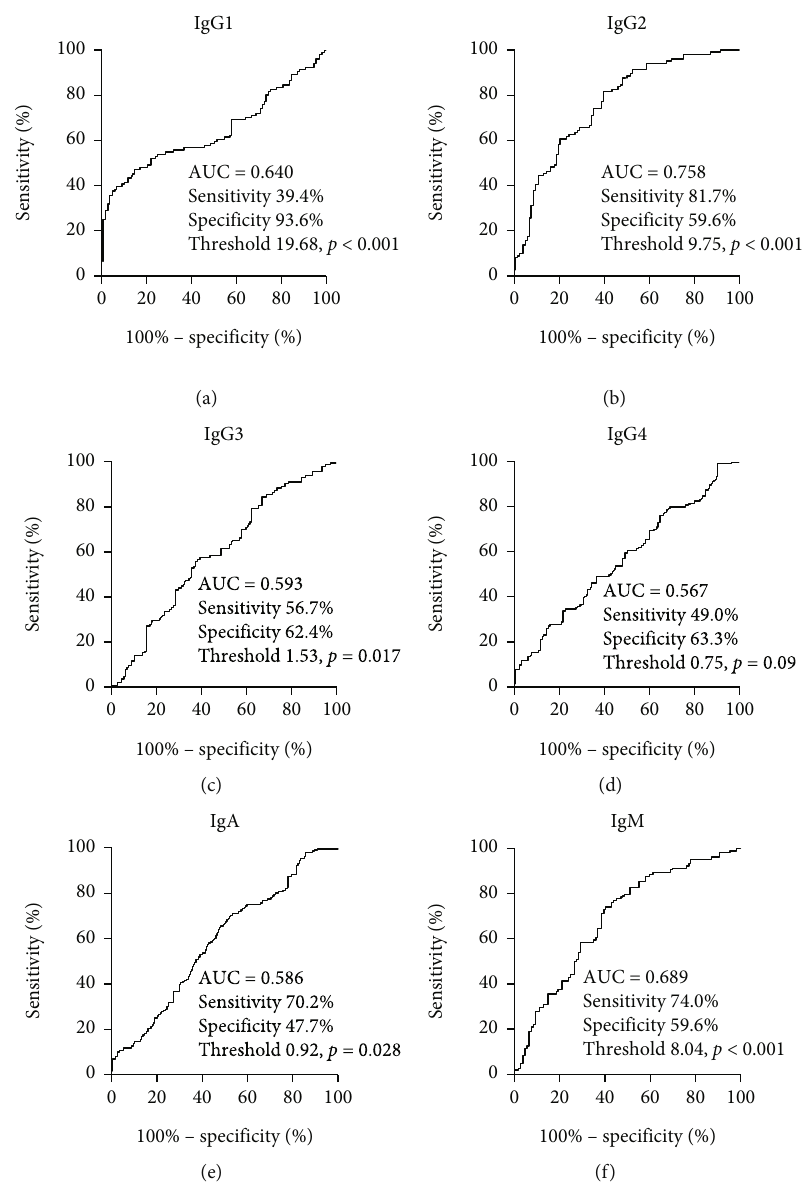
Figure 2: The ROC curve analysis of immunoglobulin test results between CWP and DEW. The ROC curve analysis was performed for (a) IgG1, (b) IgG2, (c) IgG3, (d) IgG4, (e) IgA, and (f) IgM to obtain the threshold values, sensitivity, and speci fi city. ROC: receiver operating characteristic. CWP: coal workers ’ pneumoconiosis; DEWs: dust-exposed workers; HCs: healthy